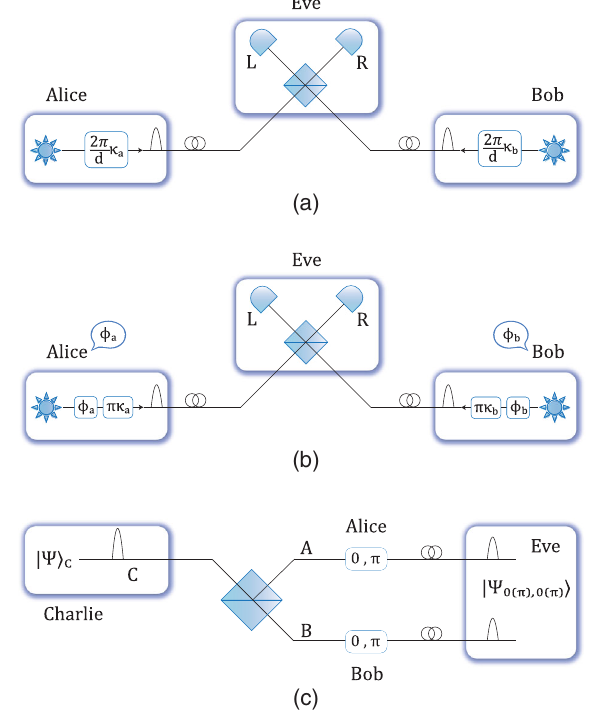
FIG. 1. (a) Schematic diagram of PM-QKD. Alice generates a ffiffiffiffiffi p e 2 π i κ μ coherent state, j a =d i , where κ a ∈ f 0 ; 1 ; … ; d − 1 g . Sim- a ffiffiffiffiffi p e 2 π i κ μ ilarly, Bob generates j b =d i . The two coherent states b are sent and interfered at an untrusted measurement site. (b) Schematic diagram of PM-QKD with d ¼ 2 plus phase ffiffiffiffiffi p e i μ ð ϕ a þ πκ a Þ i and Bob prepares randomization. Alice prepares j a ffiffiffiffiffi p e i μ ð ϕ b þ πκ b Þ i . The two coherent states interfere at an untrusted j b measurement site. If the phase difference jð ϕ a þ πκ a Þ − ð ϕ b þ πκ L clicks; if the phase difference is π , detector b Þj is 0, detector R clicks. After Eve announces her measurement result, Alice and Bob publicly announce ϕ a and ϕ b . (c) Equivalent scenario for the postselected signals with ϕ a ¼ ϕ b . A trusted party (Charlie) prepares j Ψ i C , splits it, and sends it to both Alice and Bob. Without loss of generality, we consider the case where Alice and Bob both modulate this by the same phase 0 or π to create the systems A and B . If j Ψ i C only contains odd- or even-photon number components, we can see that j Ψ 0 i ¼ j Ψ π i